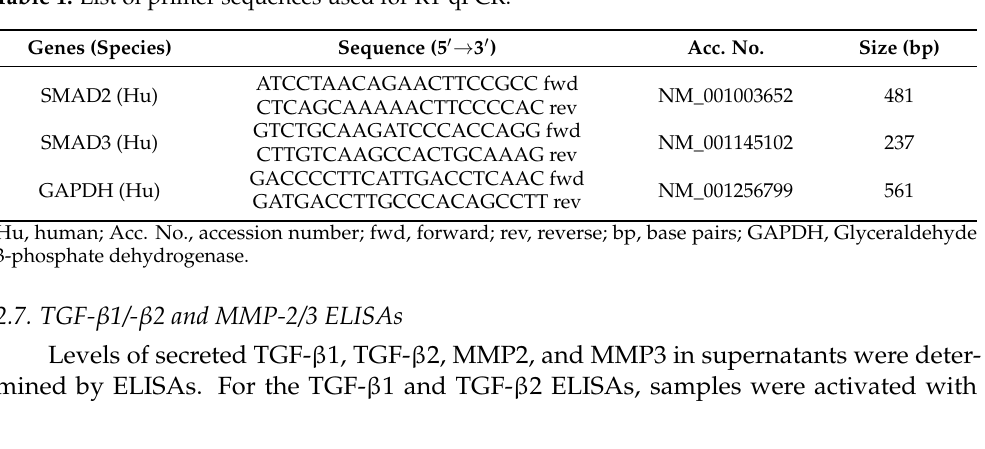
Table 1. List of primer sequences used for